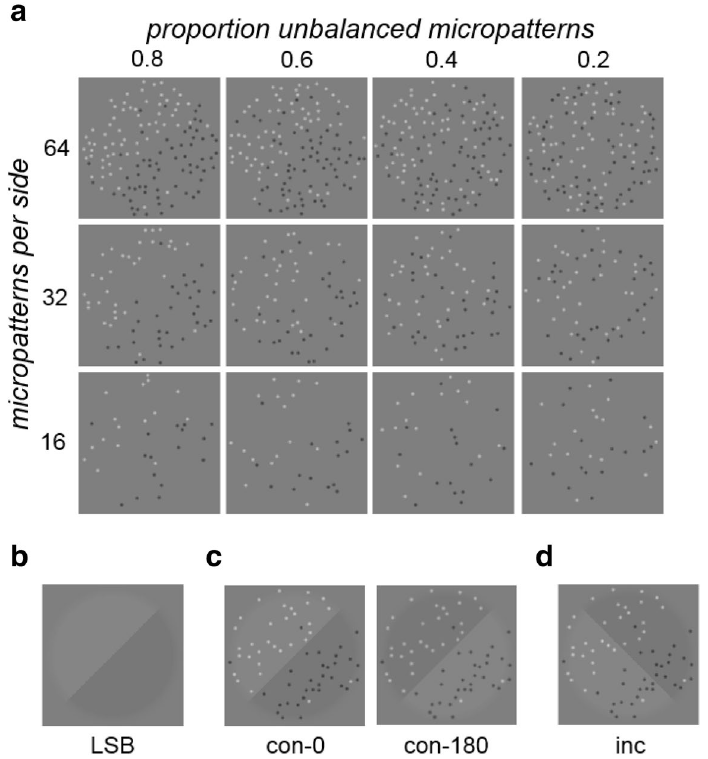
Figure 2. Stimulus images. ( a ) Examples of luminance texture boundary (LTB) stimuli used in this study, shown for varying densities (16, 32, 64 micropatterns on each side of boundary) and proportion unbalanced micropatterns ( π U = 0.2, 0.4, 0.6, 0.8). For all of these example stimulus images, the boundary is right oblique. ( b ) Luminance step boundary (LSB) stimulus. ( c ) Stimulus image examples with LTB and LSB having the same orientation ( congruent ), either phase-aligned ( con-0 ) or opposite-phase ( con-180 ). ( d ) Example image having superimposed, orthogonal ( incongruent ) luminance texture (right-oblique) and luminance step (left-oblique) boundaries ( inc